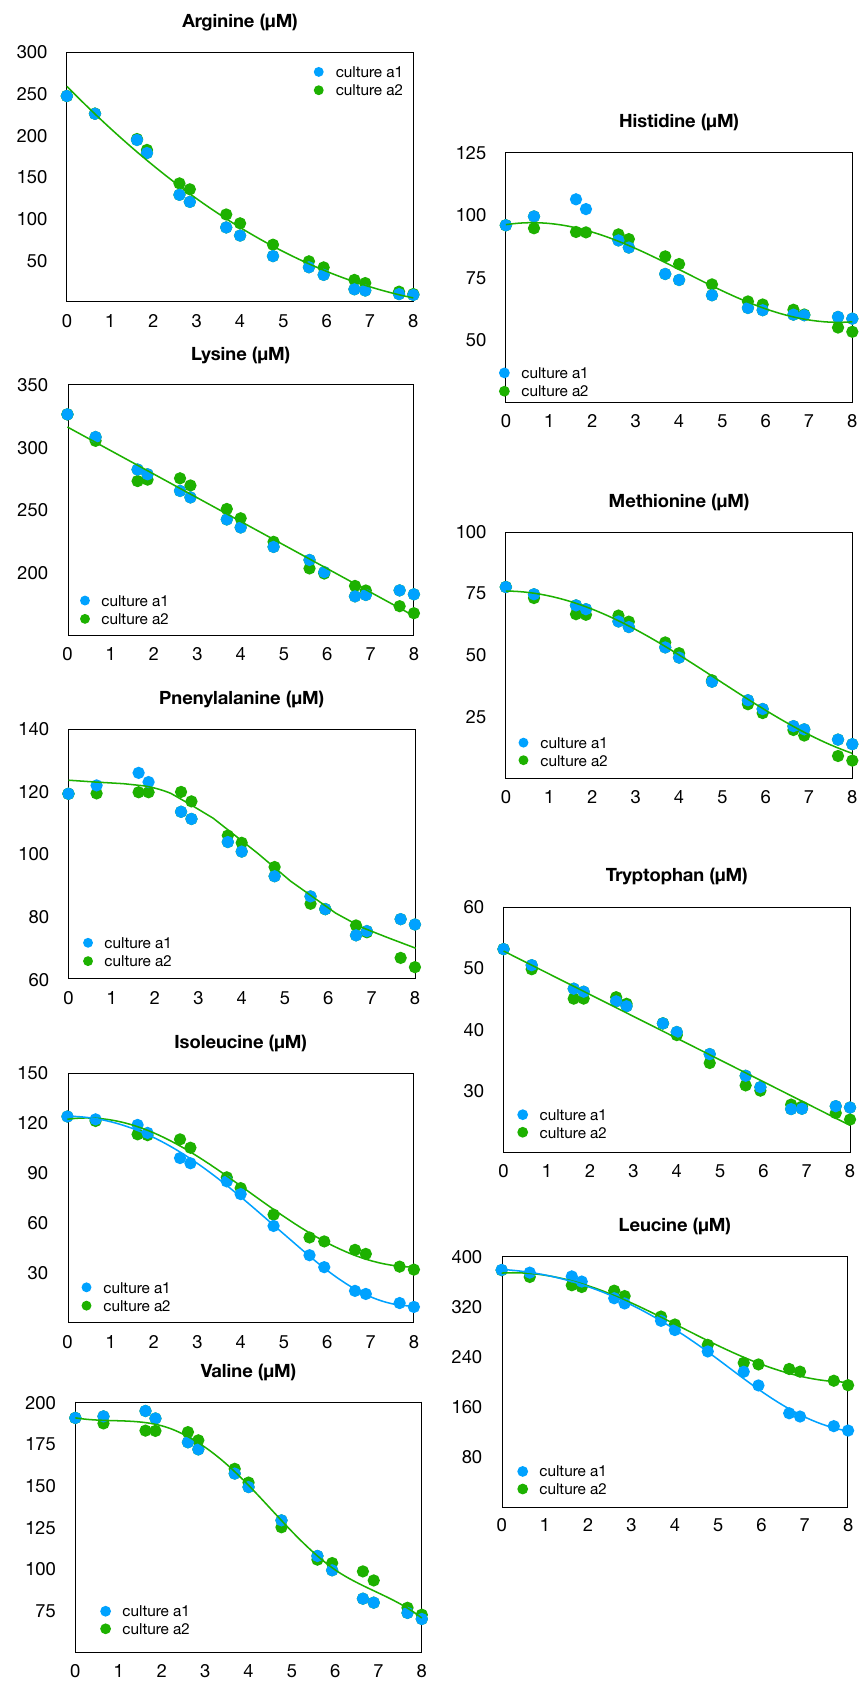
Figure 4. Time evolution of essential amino acids in cultures a1 and